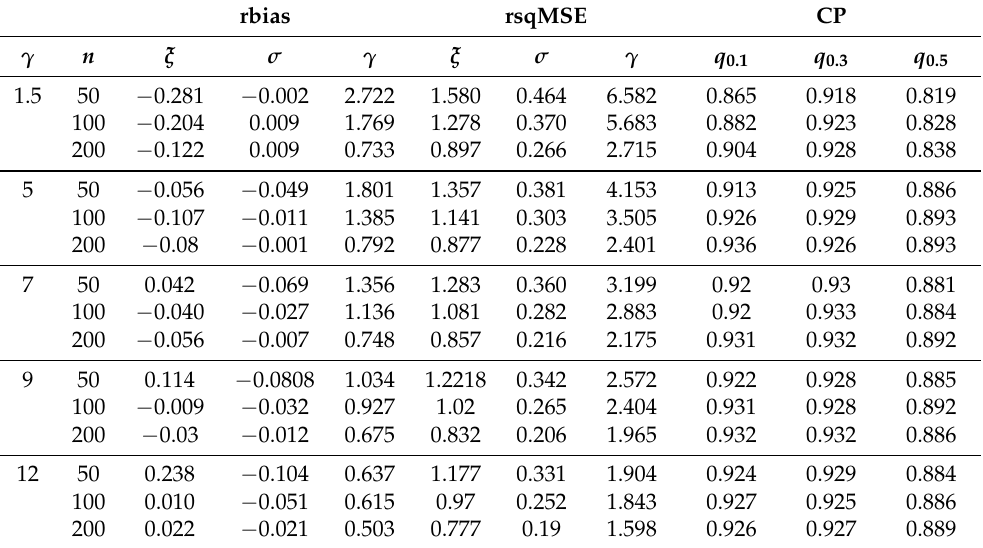
Table 11. The rbias and rsqMSE of BcLS-MLE, and the CP of S ( y 0 | Θ ) for LPN ( Θ ) with ξ = 5, σ = 5, and 1 − α = 0.95 based on the LS initial solutions by searching γ in [2,10]. rbias